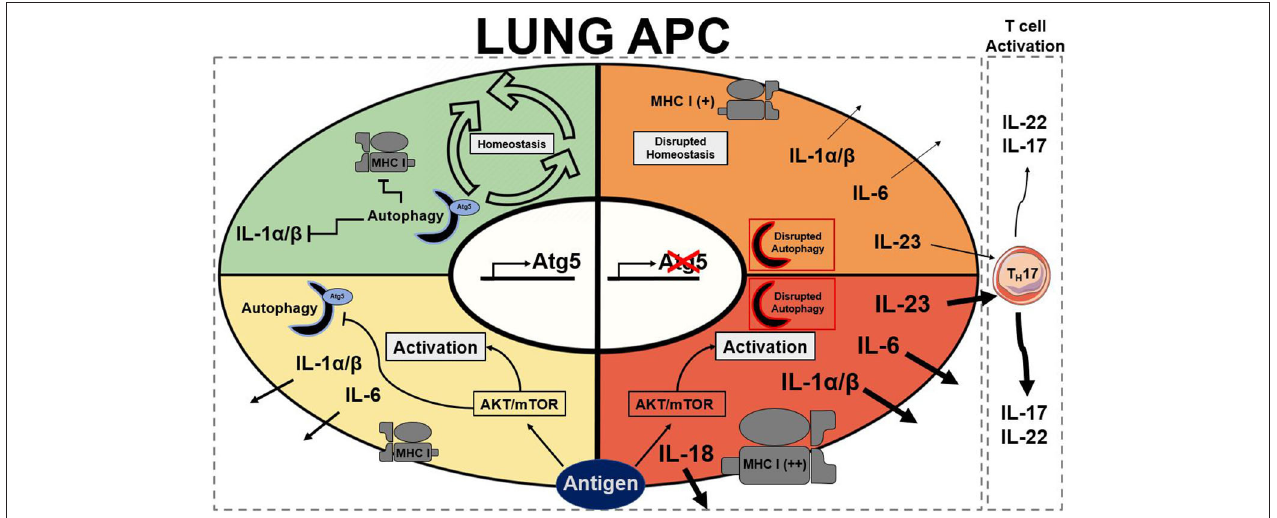
FIGURE 1 | Summary of stead state and active Atg5/Atg5 − / − antigen presenting cells. Autophagy presence is represented by a half formed autophagosome highlighted in blue for functional and red to dysfunctional autophagy. Atg5 is a requirement for functional autophagy. Each quadrant denotes activation state of a lung APC: green represents homeostasis, yellow represents moderate activation, orange represents moderate to high activation, and red represents high activation. AKT, protein kinase B; APC, antigen presenting cell; Atg5, autophagy related 5; MHC I, major histocompatibility complex class I; mTOR, mechanistic target of rapamycin (25, 30, 74, 77, 79,